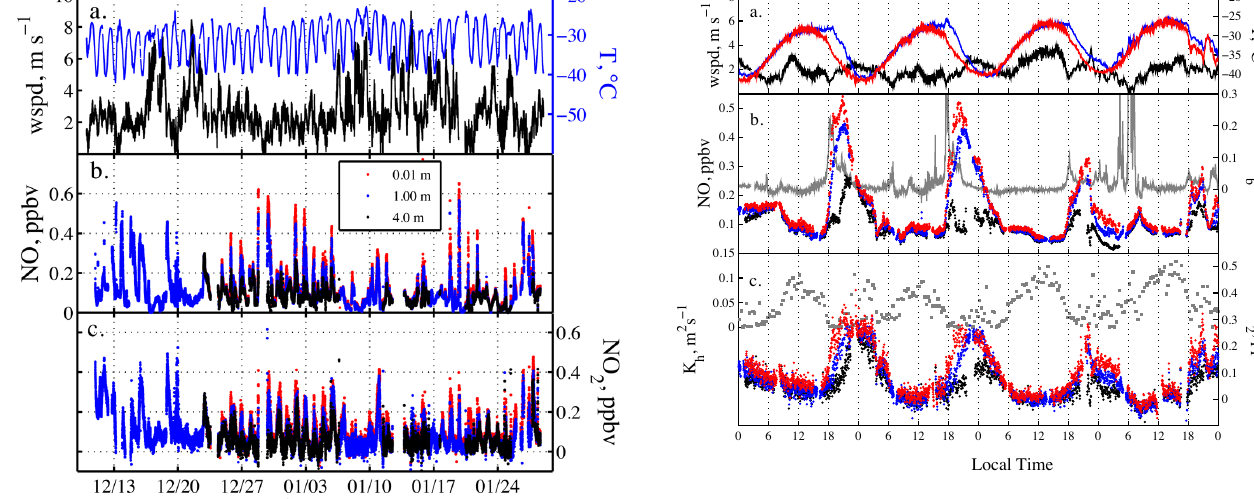
Fig. 4. Diurnal variability during 1–4 January 2010: (a) wind speed (wspd) at 3m (black line), temperatures ( T ) of air at 1m (blue line) and the snow surface (red line), (b) NO mixing ratios at three heights and bulk Richardson number ( Ri b ) (grey line) and (c) NO 2 mixing ratios at three heights and turbulent diffusion coefficient of heat ( K h ) at 1m (grey symbols). Mixing ratios at 0.01, 1.0 and 4.0m are shown as red, blue and black symbols, respectively.